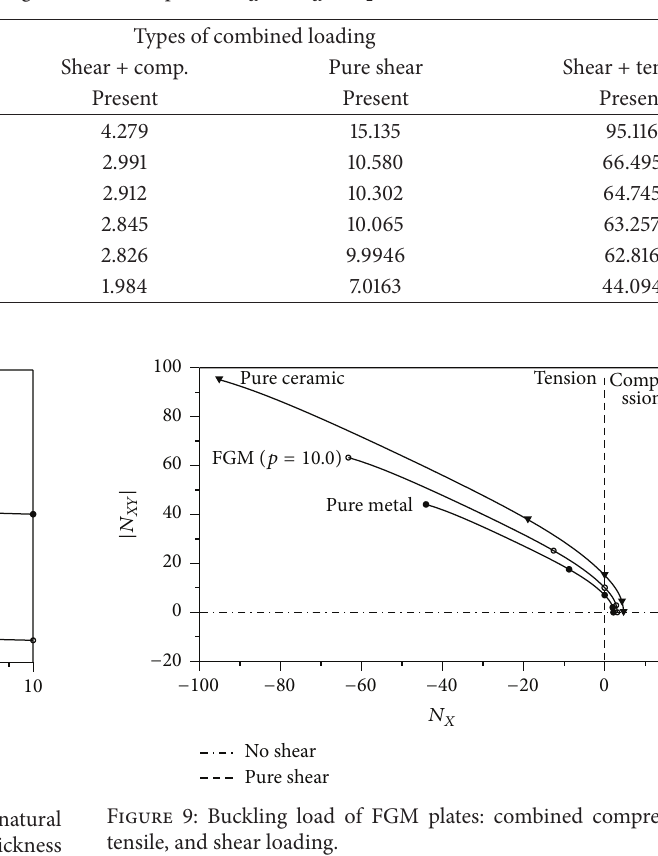
Table 10: Nondimensional buckling loads of FGM plates (𝑁